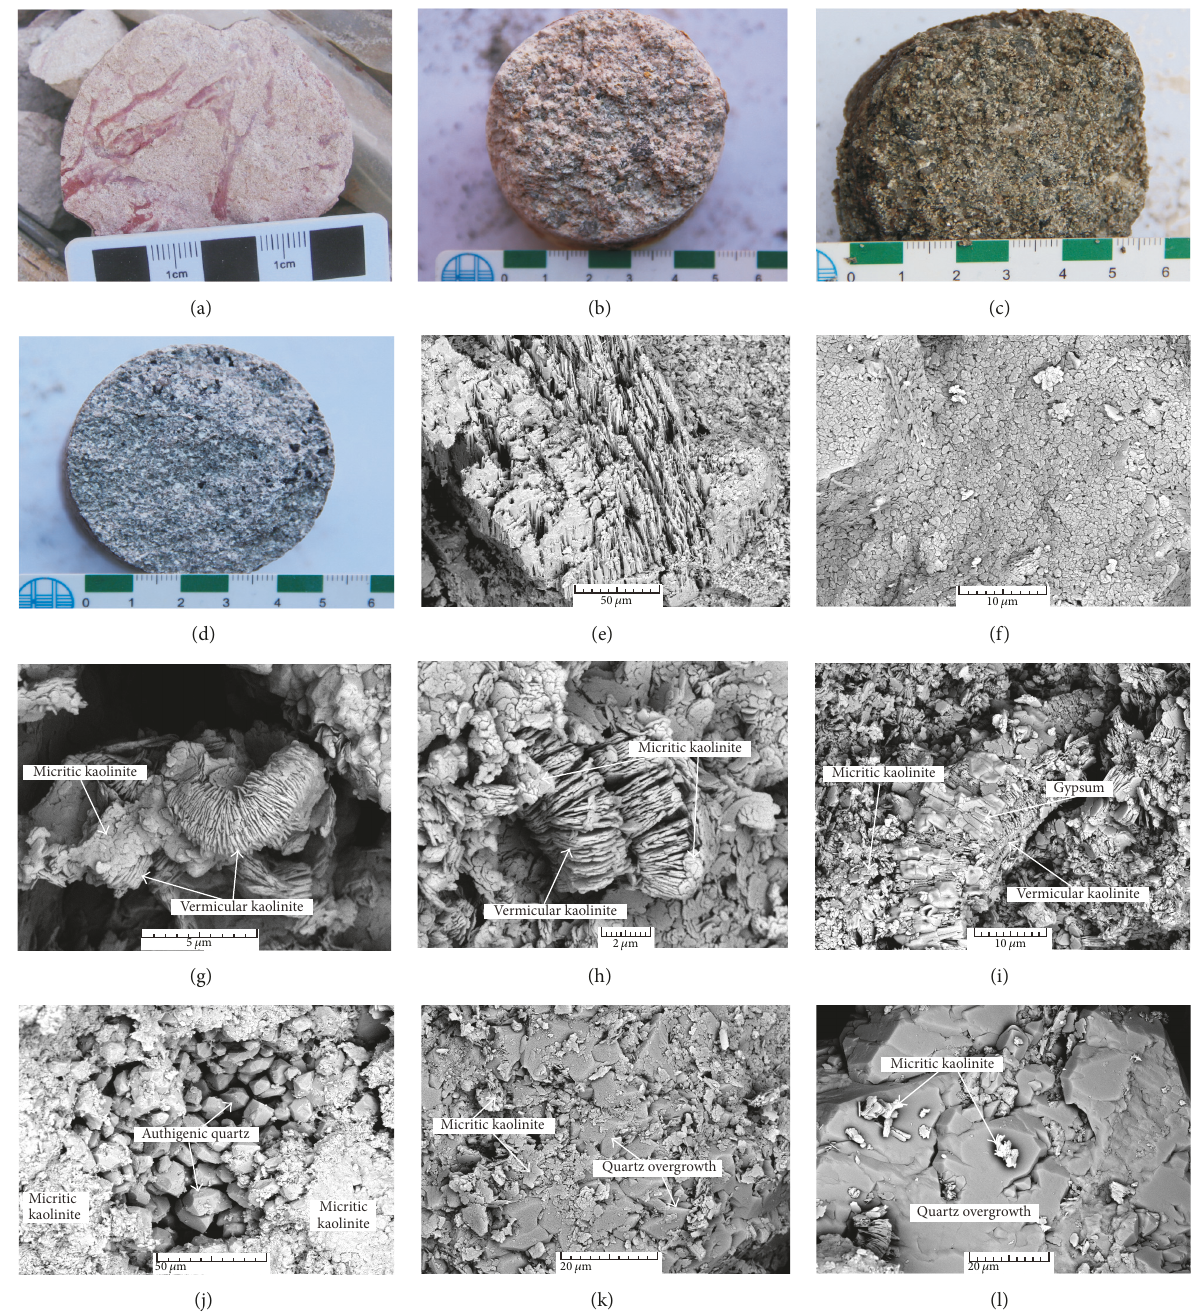
Figure 3: (a) Red sandstone with oxidized organic moulages in strong oxidation zone. (b) Yellowish-white sandy conglomerate dotted with red limonite in weak oxidation zone. (c) Gray mineralized sandy conglomerate. (d) Grayish-white sandstone containing carbon debris in primary zone. (e) Leached feldspar grain and pores filled with micritic kaolinite. (f) Micritic kaolinite covering quartz grains. (g) Vermicular kaolinite coexisting with micritic kaolinite. (h) Vermicular kaolinite superposed by micritic kaolinite. (i) Micritic kaolinite coexisting with gypsum and superposed upon vermicular kaolinite. (j) Authigenic quartz grains in intergranular pore covered by micritic kaolinite. (k) Strong quartz overgrowth covered by micritic kaolinite. (l) Quartz overgrowth replaced with micritic